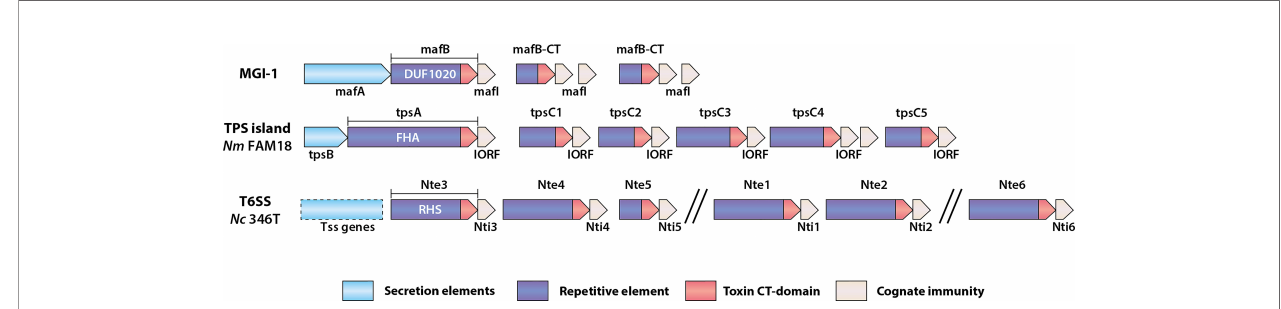
FIGURE 1 | Schematic of genomic organization of polymorphic toxin system loci found in Neisseria species. Examples of a Maf genomic island, a TPS island and T6SS associated effectors are shown. MGI-1 is the consensus organization of this island (Arenas et al., 2015; Jamet et al., 2015), whereas the TPS island and T6SS locus indicated are from N. meningitidis (Nm) FAM18 (Arenas et al., 2013) and N. cinerea CCUG346T (Custodio et al., 2021), respectively. The secretion elements of the Maf and Tps toxins are different between systems but are generally located in the 5 ’ -end of the genomic islands. mafB includes a region encoding a domain of unknown function named DUF1020, tpsA includes a region encoding a fi lamentous hemagglutinin adhesin (FHA) domain, whereas T6SS effector genes like those described in N. cinerea (Nc) include regions encoding Rearrangement Hot Spot (RHS) domains. The repertoire of toxin genes is diverse, but each is followed by